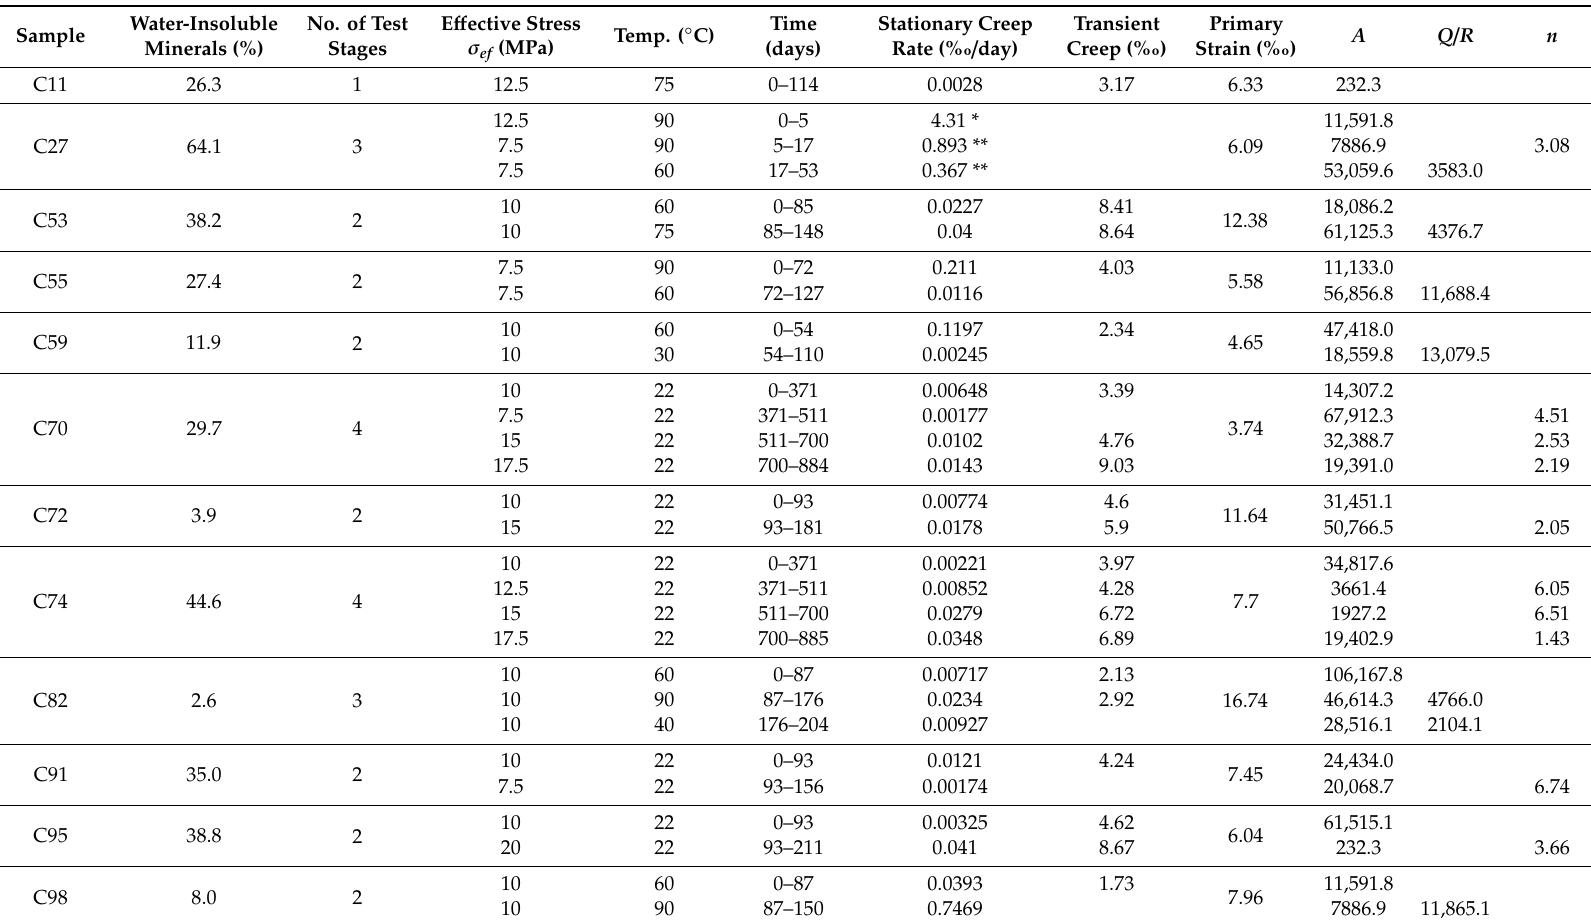
Table A3. Load-thermal conditions and the results of the rheological tests—the Red Zuber unit samples (according to